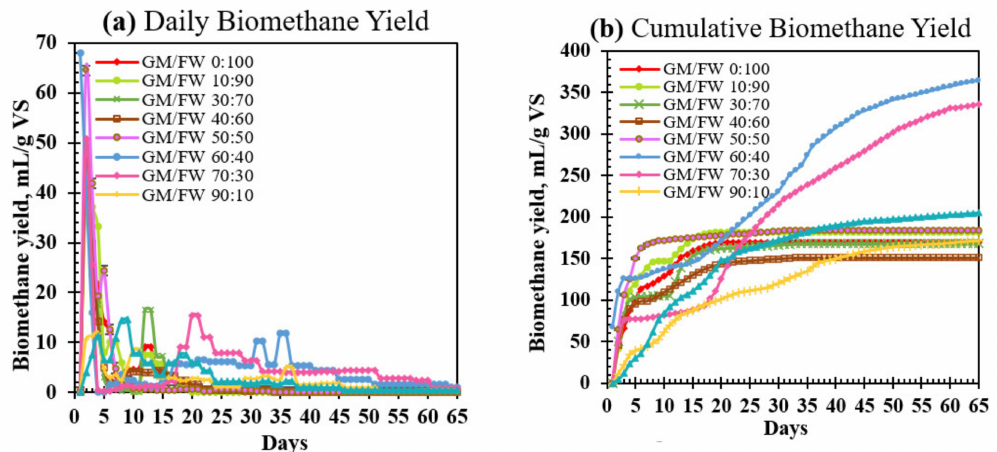
Figure 2. Biomethane yields: ( a ) Daily and ( b ) Cumulative (mL/gvs)